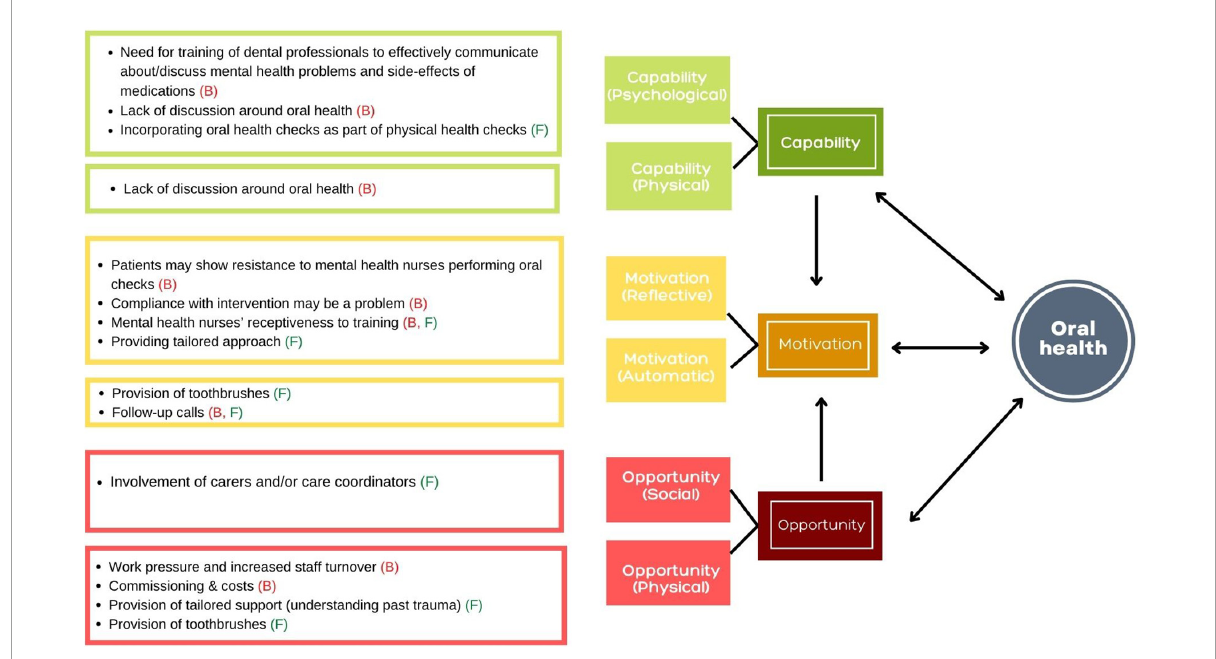
FIGURE2 The barriers (B) and facilitators (F) reported by the service providers on three main themes according to the COM-B